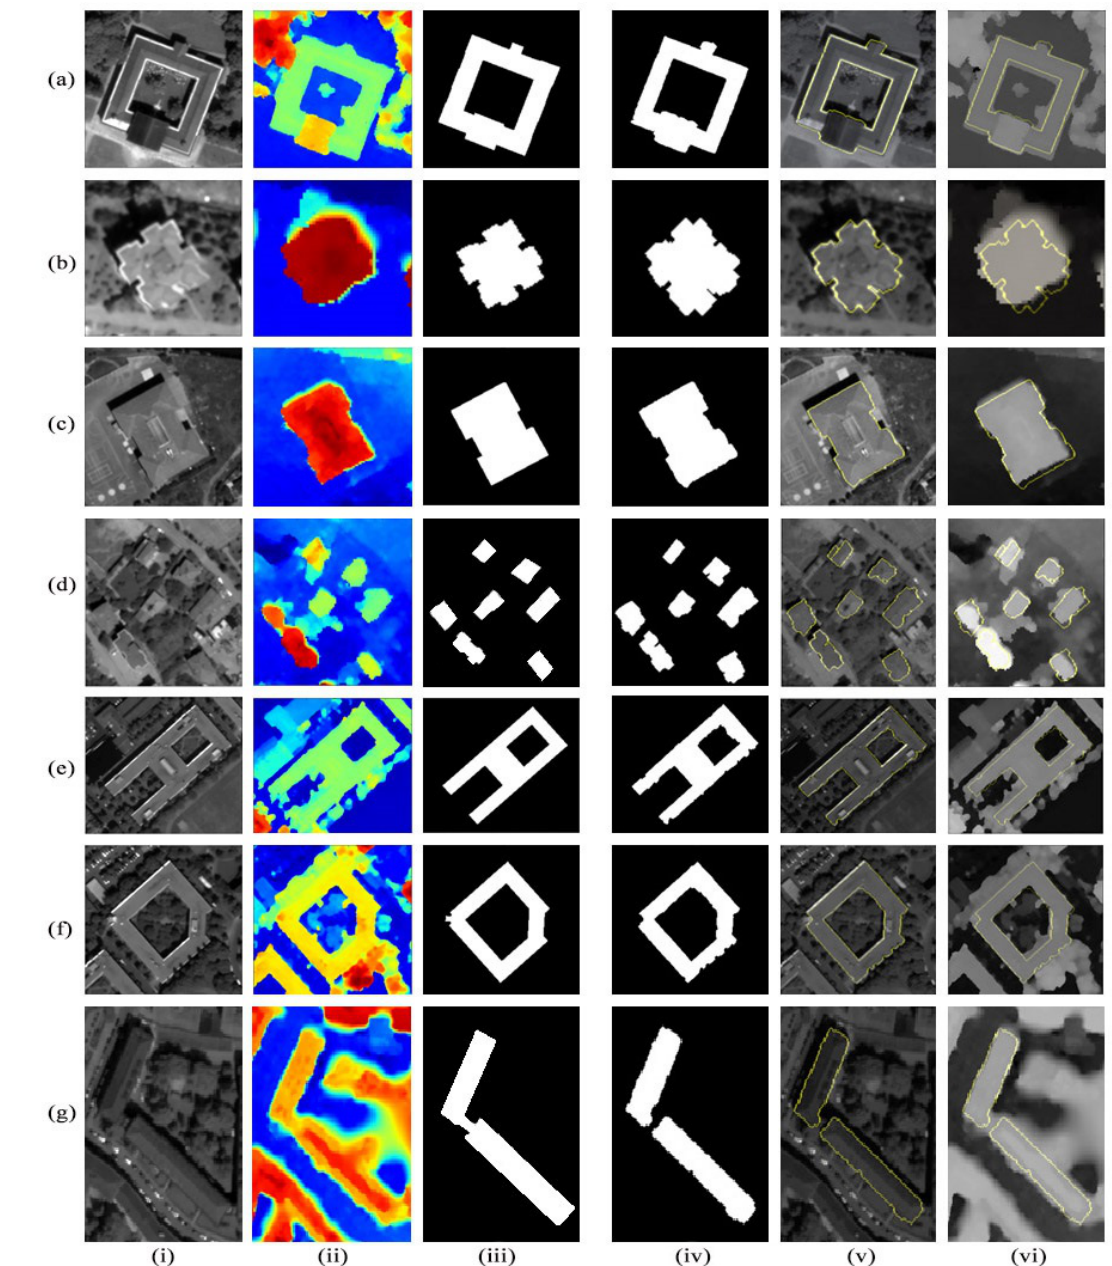
Figure 10. Results for 7 test data ( a – g ); ( i ) pan image, ( ii ) DSM, ( iii ) ground truth, ( iv ) result as extracted mask, ( v ) result as footprint overlaid on the pan image, ( vi ) overlaid on the